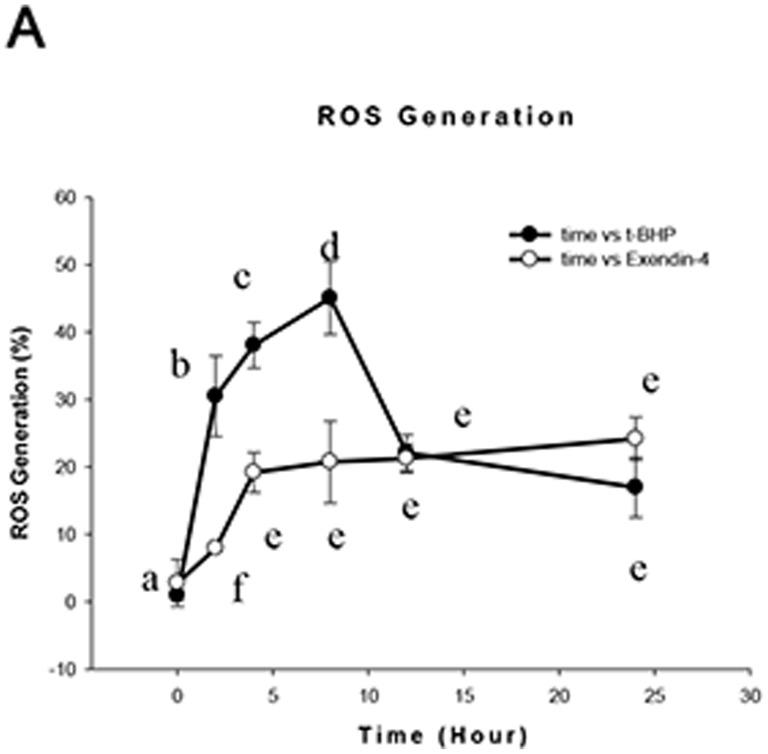
Exendin-4 reduces t-BHP-induced ROS production.Cells were treated with or without Exendin-4 and then with t-BHP for different intervention times, collected, stained with 2 µM HE and analyzed with an absorbance microplate reader. Values are expressed as percentages of total cell counts. The data are expressed as the means±S.D. (n = 6). a, b, c, d and e indicate the t-BHP groups and Exendin-4 groups at different intervention times (p<0.05).